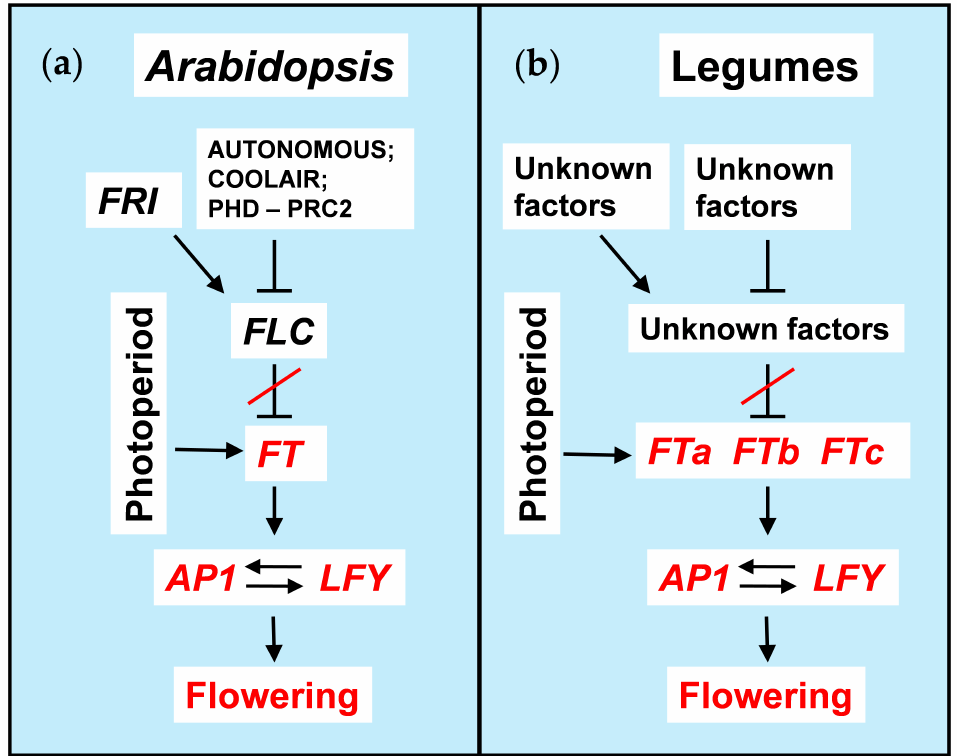
Figure 1. Flowering promotion by vernalization. ( a ) A generalized regulatory mechanism of cold- induced flowering promotion in Arabidopsis , ( b ) a putative regulatory network in legumes. Arrows and T-bars show positive and negative regulatory interactions respectively. Activation state of the core components is shown with the red color. ‘Autonomous’ and ‘Photoperiod’ denote the corresponding pathways in A. thaliana . FTa , FTb and FTc are three subclades of FT orthologs in